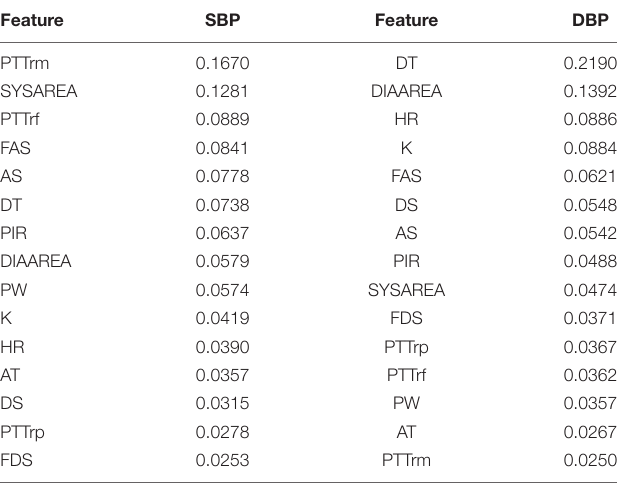
TABLE 4 | Average group importance levels of PTTs and PPG features for blood pressure